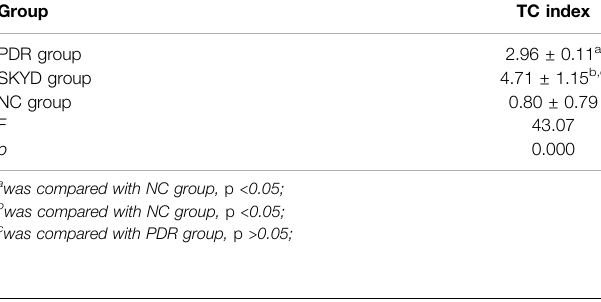
TABLE2| Triglyceridesindexinthreegroupsofmice(mean ± standarddeviation). Group